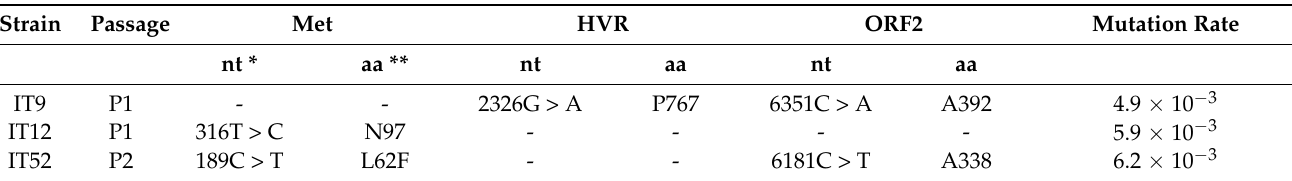
Table 3. Mutations observed on sequences of three genomic regions (Met, HVR and ORF2) of HEV isolates obtained after cell cultivation at 9 weeks